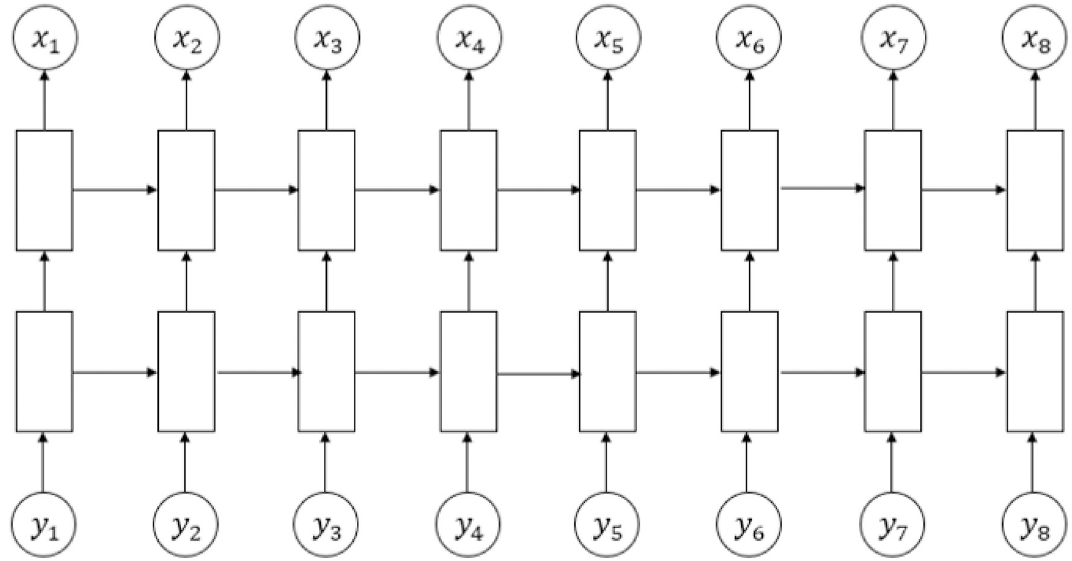
Fig 4. The structure of the LSTM we build to predict CPI fluctuation states using historical CPI series.